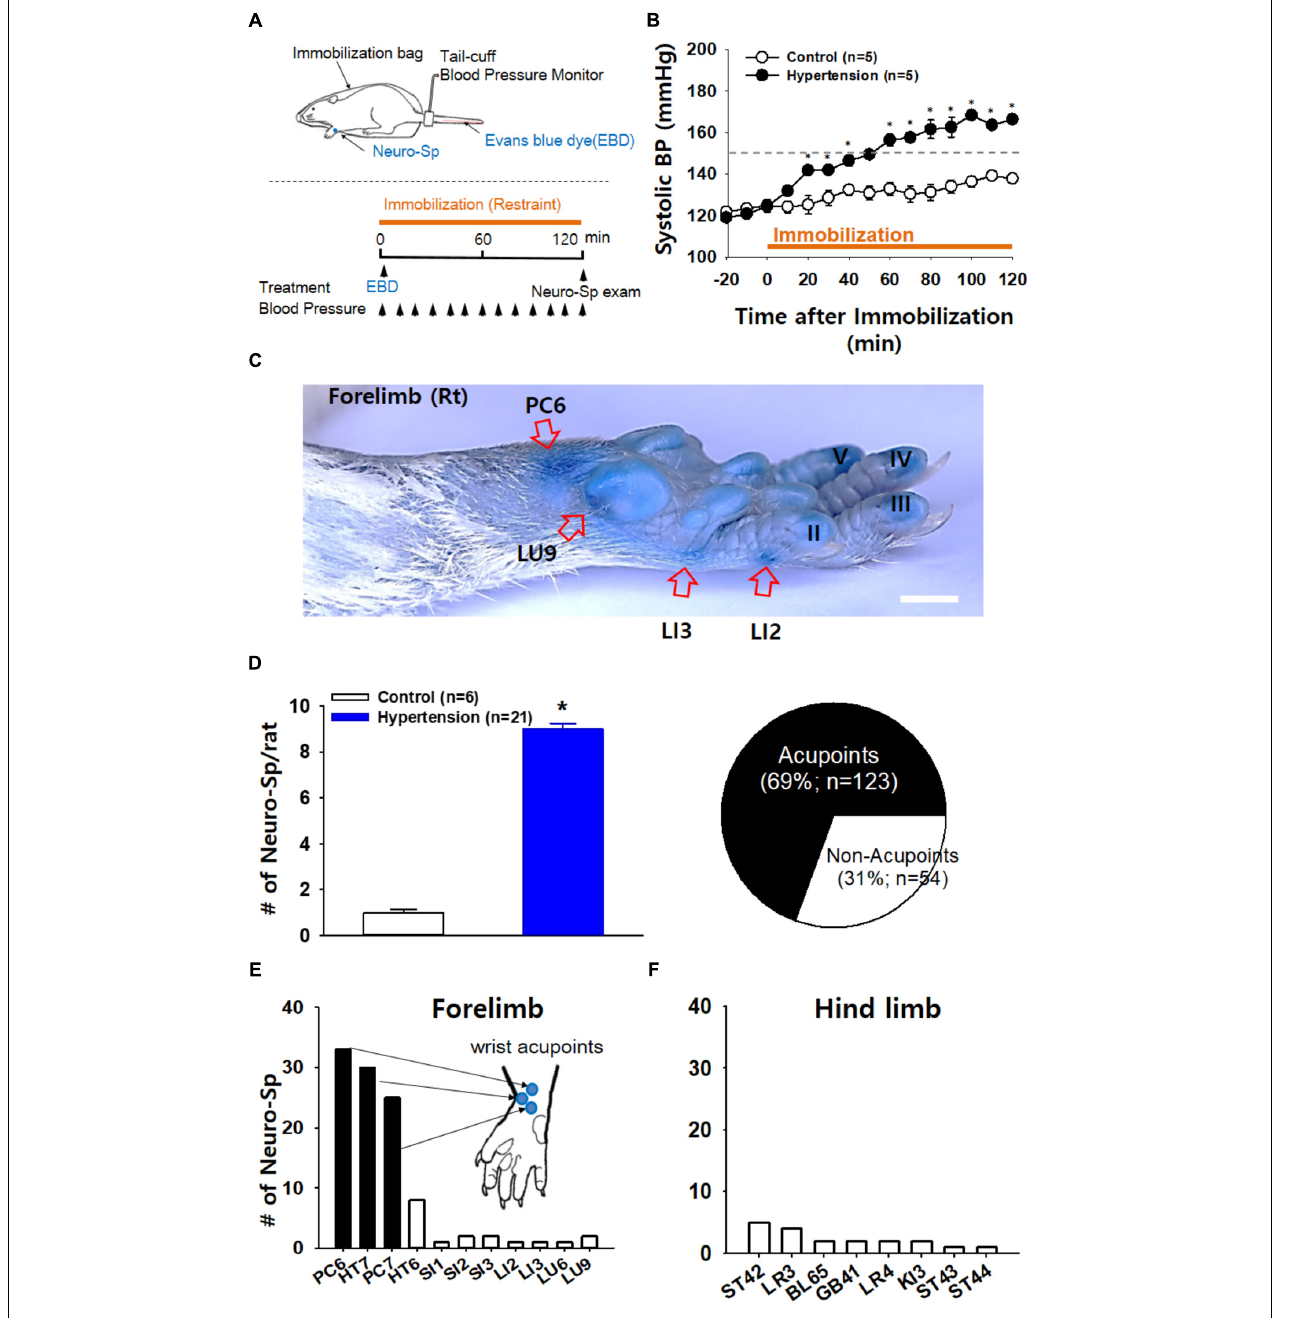
FIGURE 1 | Neurogenic inflammation at acupoints in IMH rats. (A) Schematic of the experimental procedure in the rat model of immobilization-induced hypertension (IMH). Evans blue dye (EBD); neurogenic inflammatory spots [neurogenic spots (Neuro-Sp)]. (B) Development of hypertension following immobilization (restraint). In restrained rats, systolic blood pressure (systolic BP) was significantly elevated, reaching the level of hypertension over 150 mmHg within 1 h, compared to that in unrestrained control rats (control). ∗ p < 0.001 vs. control. (C) A representative image of Neuro-Sp in an IMH rat. (D) Numbers of Neuro-Sp per animal (bar graph) and correlation of the anatomic location between Neuro-Sp and acupoints in hypertensive rats ( n = 21 animals; pie graph). Numbers of Neuro-Sp corresponding to acupoints in the forelimb (E) or hind limb (F) . Bar = 20 mm.